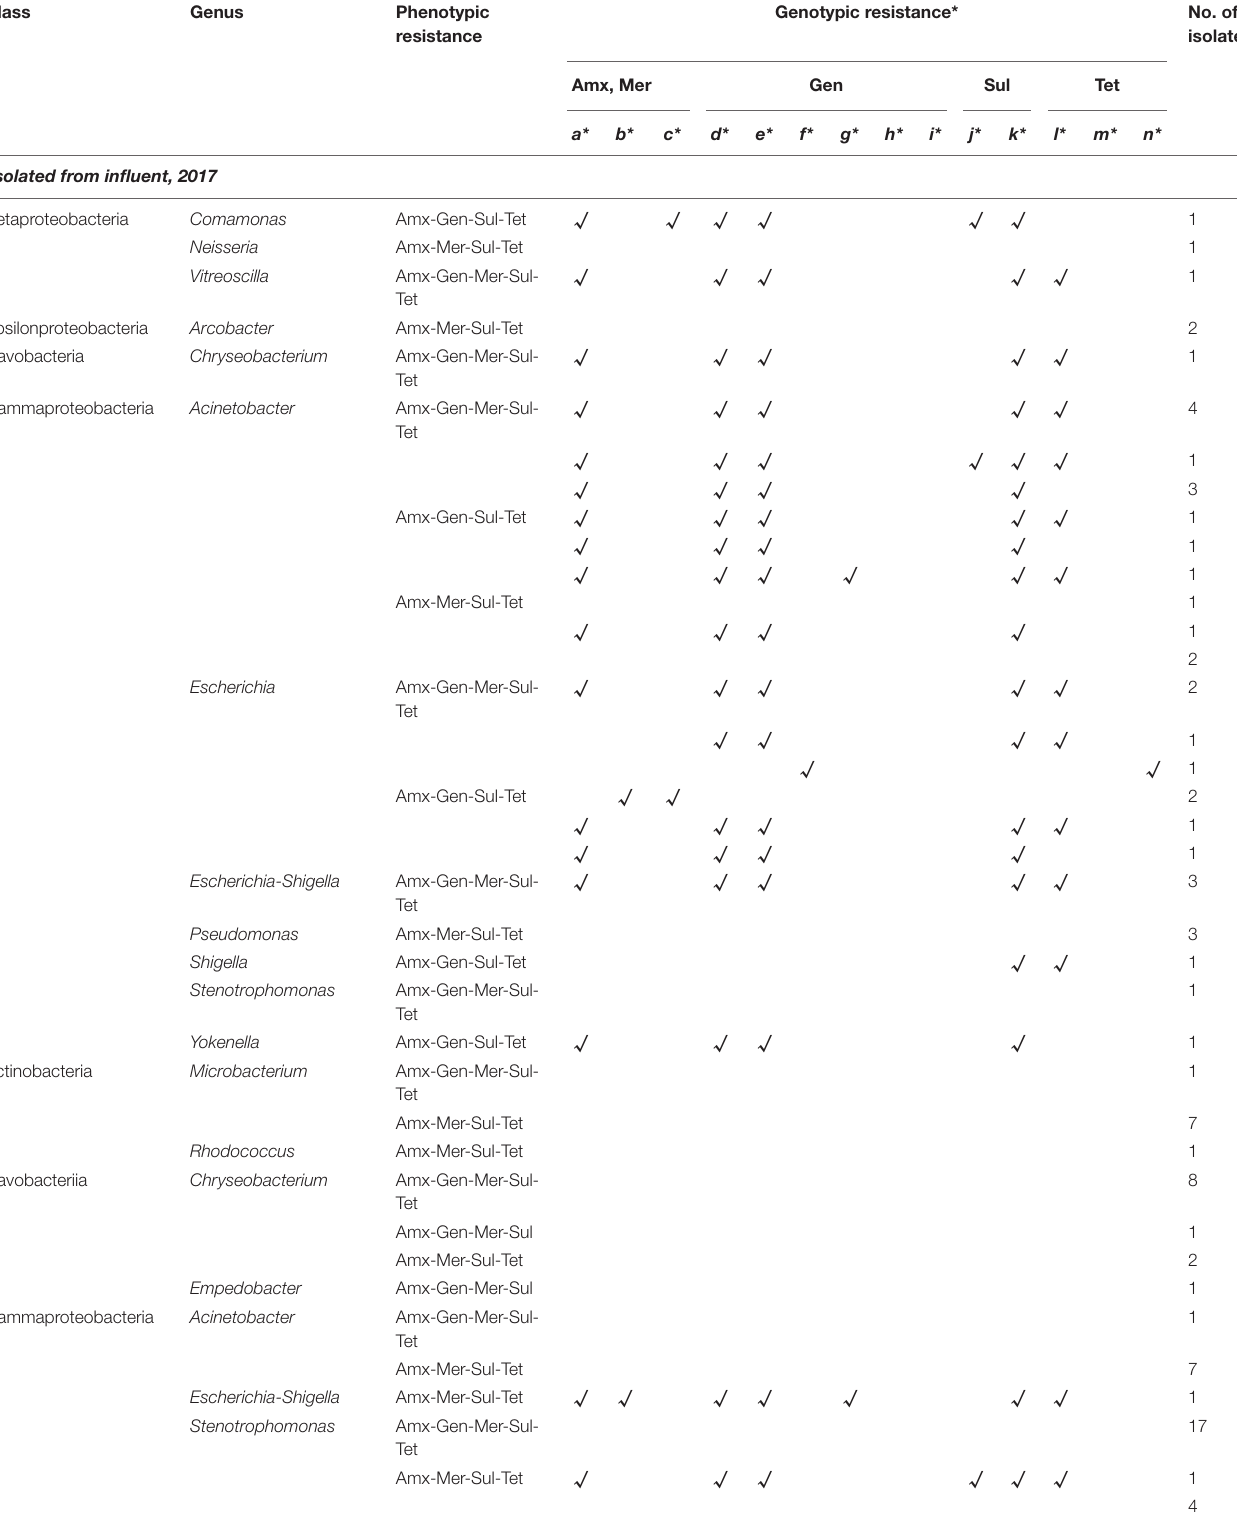
TABLE 1 | Phenotypic and genotypic resistance profile of multidrug-resistant bacteria isolated from Jungnang (JN) wastewater treatment plant (WWTP) in 2017.